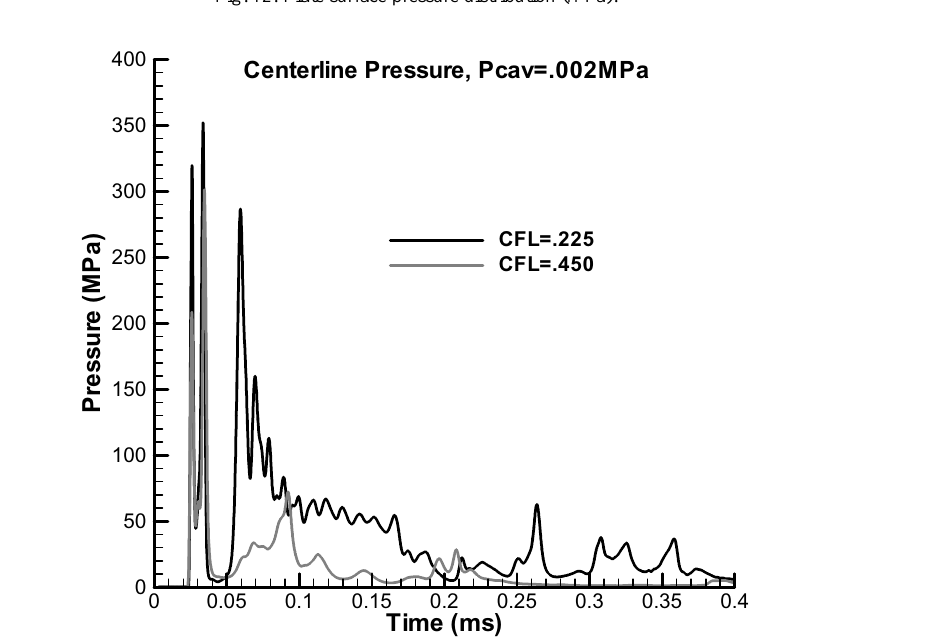
Fig. 13. Influence of step size on centerline